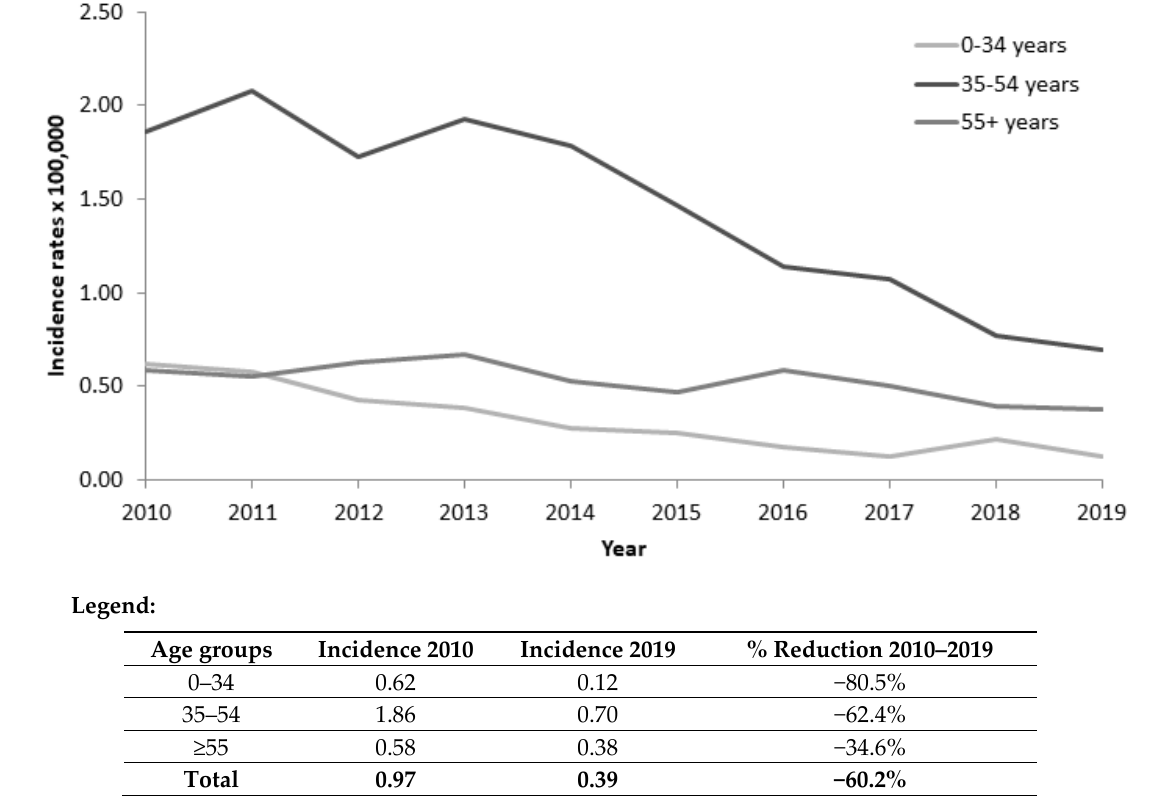
Figure 2. Age-specific incidence rates (number of cases per 100,000 inhabitants) of acute hepatitis B in Italy. SEIEVA 2010–2019. Table 1. Main features of acute hepatitis B in Italy by decade. SEIEVA